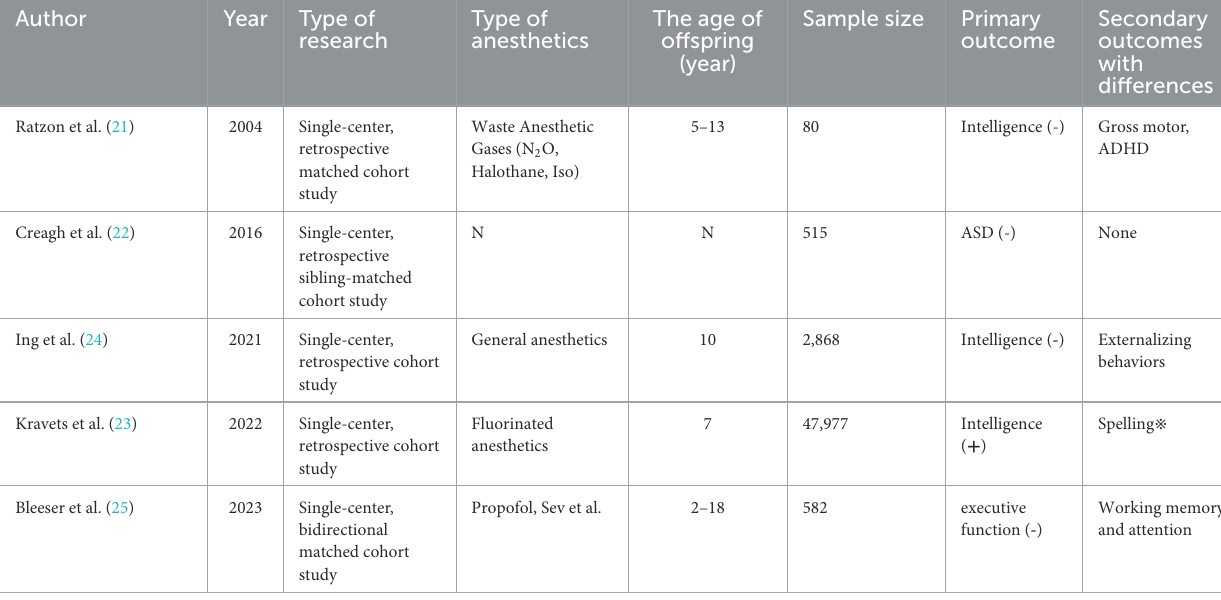
TABLE 1 Characteristics of studies on the association between PAE and offspring neurodevelopment.